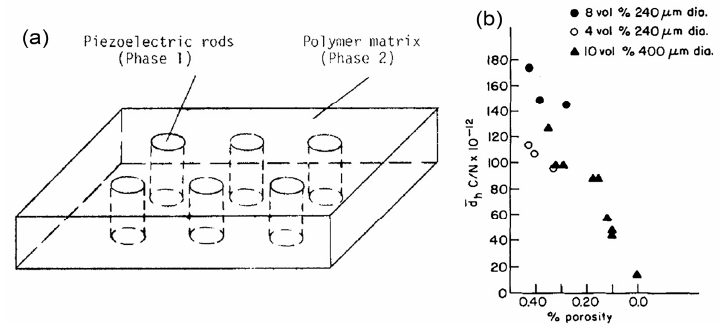
Figure 13. ( a ) Composite with 3-1 connectivity in which rods of piezoelectric are embedded in a three-dimensionally continuous polymer. PZT rods can be poled along the length and thus the direction of the PZT/epoxy composite is along the direction of the rods alignment [73]. ( b ) The measured hydrostatic piezoelectric constant of a composite PZT/foamed PU as a function of porosity in PU matrix [74].